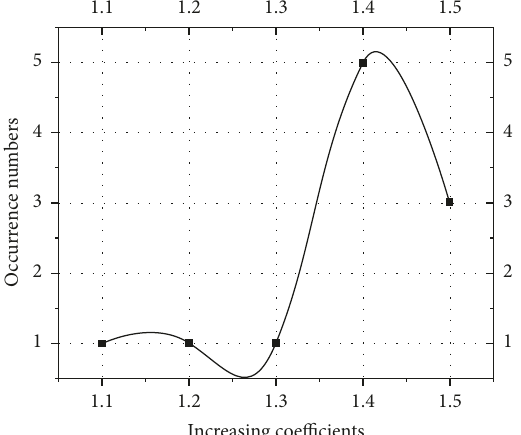
Figure 16: Increasing coefficients of the pole 13’s axial force in the gap interval [0-0.7].